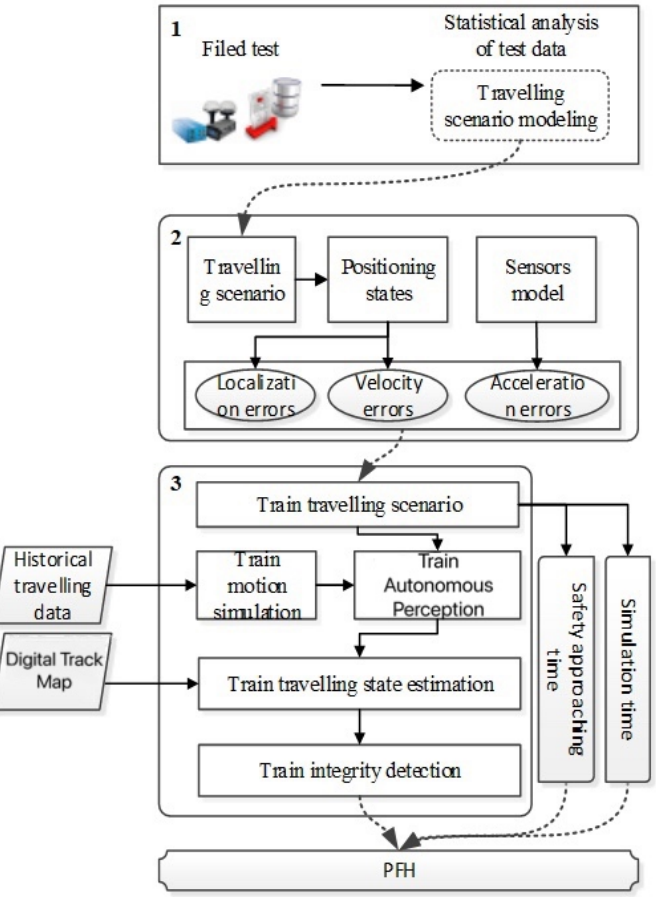
Figure 7. Verification procedure based on the analysis of experiments data.